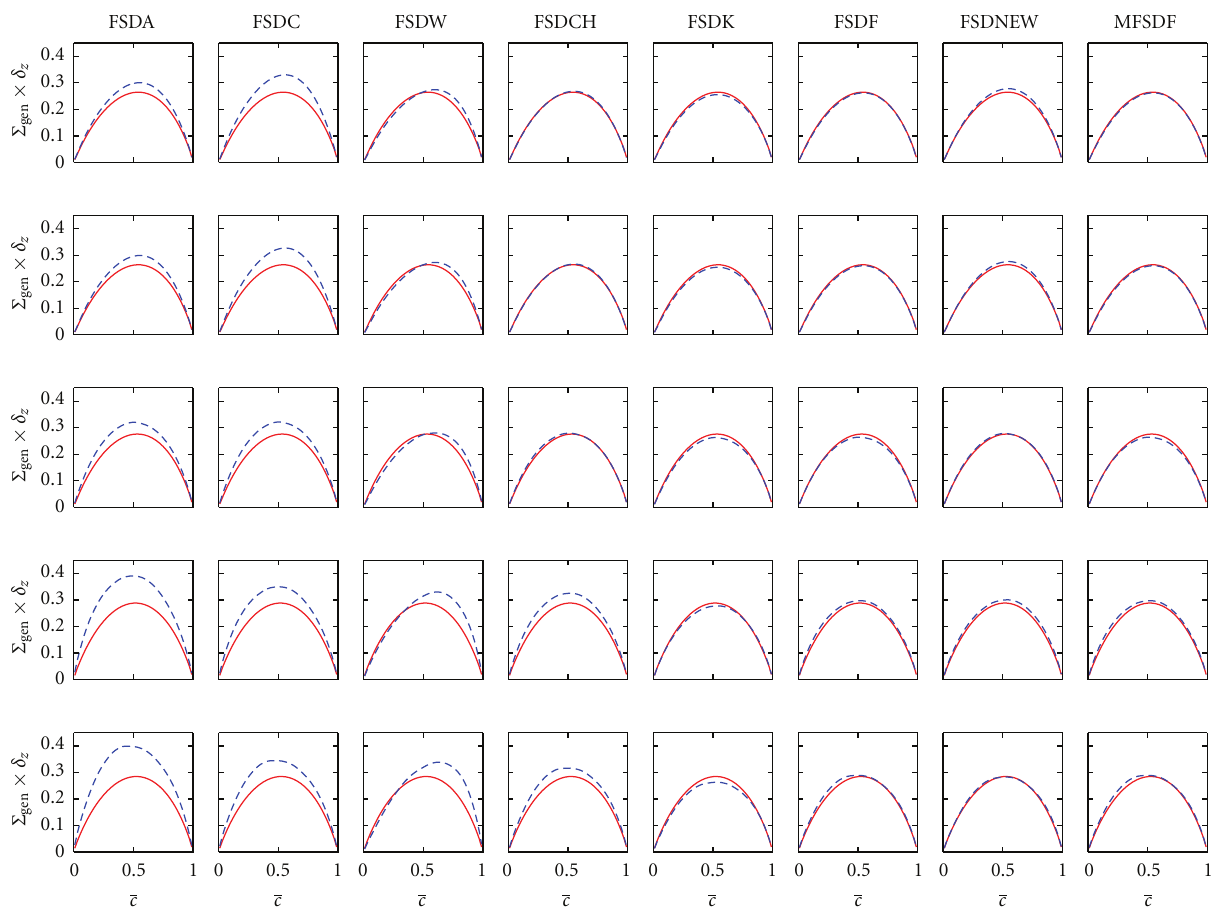
Figure 5: Variation of the mean values of Σ gen × δ z conditional on c across the flame brush for Δ = 24 Δ m = 2 . 4 δ th according to the DNS ( ) and model ( ) for cases A (1st row), B (2nd row), C (3rd row), D (4th row), and E (5th row). various Σ gen models for Δ = 2 . 4 δ th than for Δ = 0 . 8 δ th .